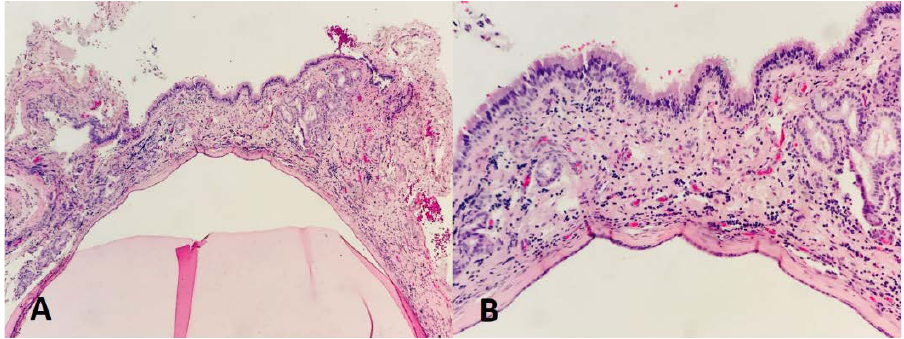
Figure 4. Histopathological assessment of the excised lesion: ( A , B ) showing pathological features of an antral pseudocyst with subepithelial inflammation that is composed of serum material and intermixed with inflammatory cells, covered by the sinus epithelium wall.